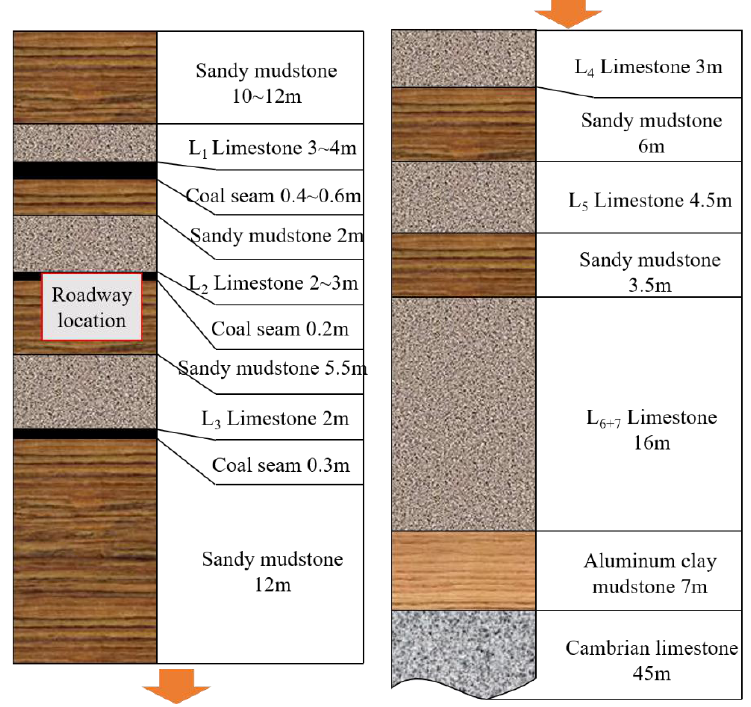
Figure 1. Stratigraphic column diagram of the bottom slab roadway of 33190 machine roadway.